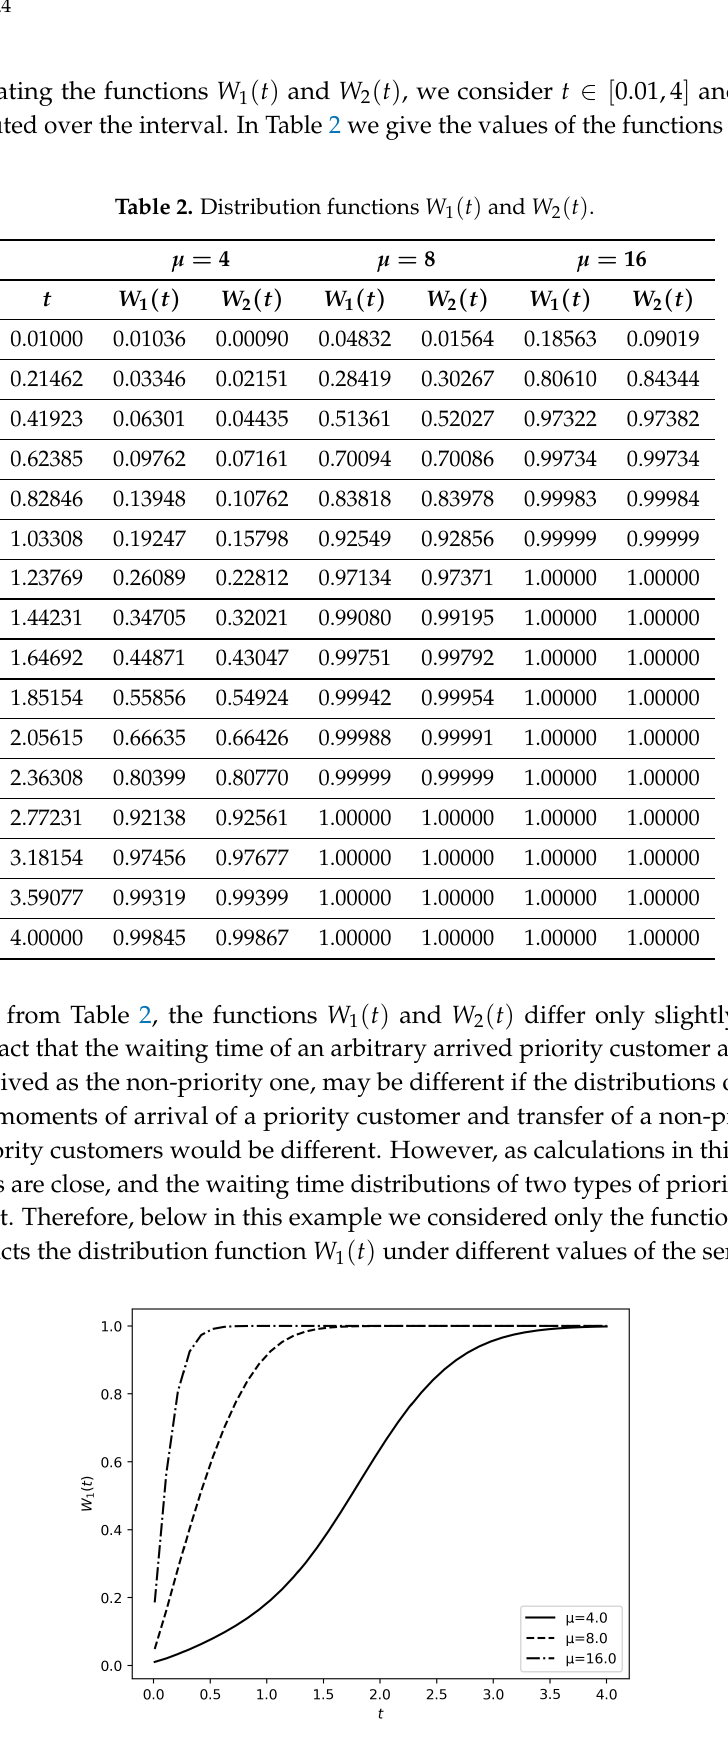
Figure 2. The distribution function W 1 ( t ) under different service rate µ